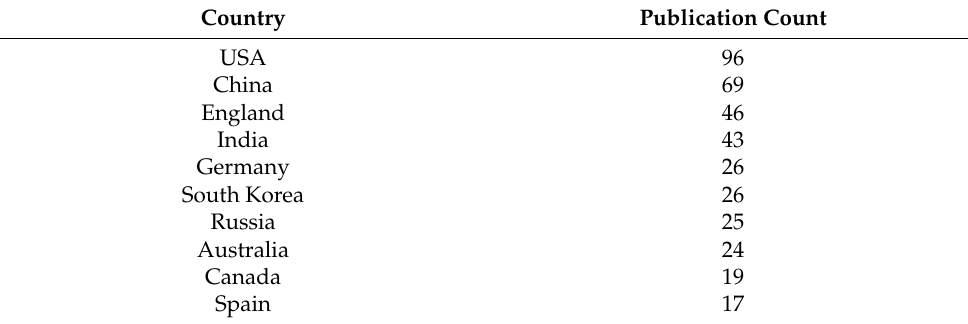
Table 8. Publication count by geographical area (WoS core collection).